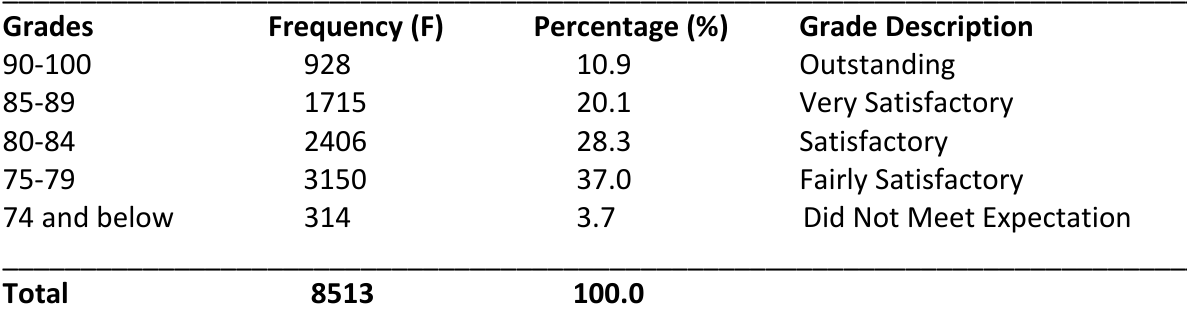
Table 3 : Overall Students’ Progress in Science of the Different